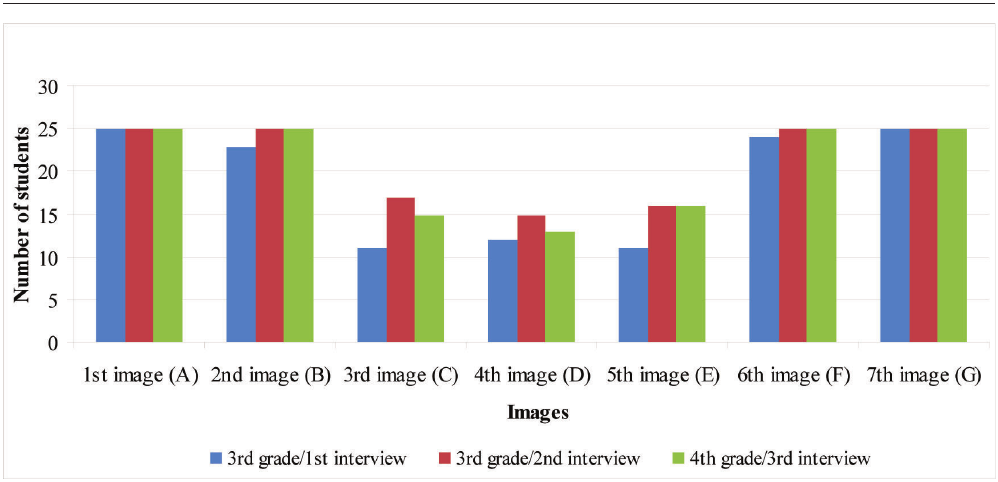
Figure 2: Number of students who correctly ordered pictures in the third grade (first and second interview) and fourth grade (third